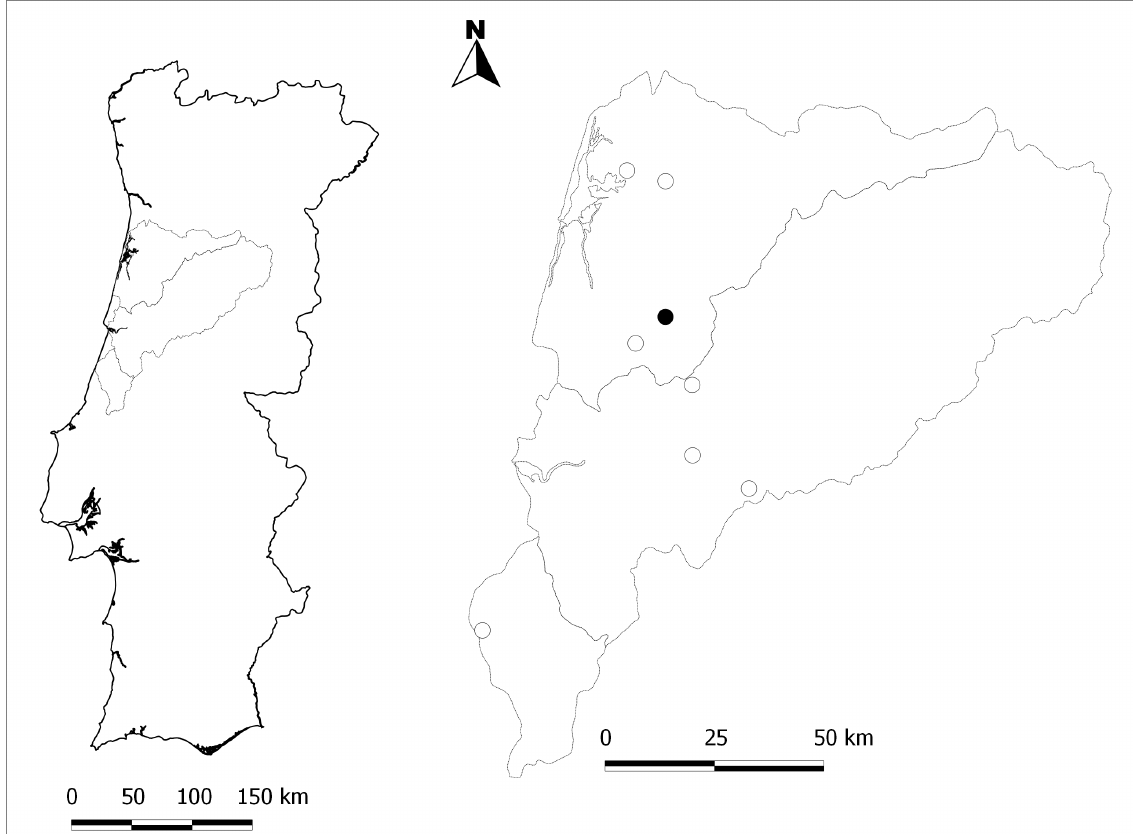
Fig. 1. Geographic locations of the sampling sites where Fragilaria rinoi Almeida & C.Delgado sp. nov. was found. The type locality is represented by a black circle in the Vouga river basin followed south by river Mondego and Lis